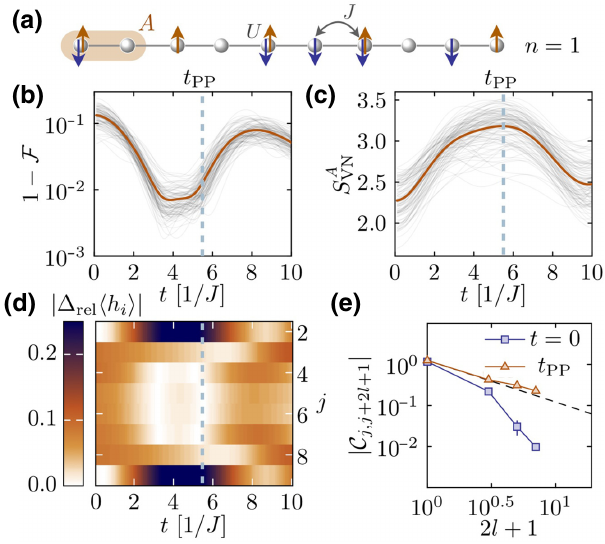
FIG. 14. Purification preparation for a ten-site Hubbard model with U / J = 1 and 50% filling ( n = 1). (a) Sketch of the Fermi- Hubbard chain with n = 1. (b) Fidelity [Eq. (10) in main text] computed between a bulk subsystem ( B ) of the ten-site chain and a corresponding subsystem in the ground state of a 200- site chain, during time evolution with the deformed Hamiltonian. The gray lines show the results for 100 different random super- positions for the initial state (see main text). The bold solid line represents the mean over all experiments for different initial states. (c) Analogous plot to (b) for the von Neumann entan- glement entropy of the subsystem A indicated in (a). (d) Local (cid:7)ˆ energy densities h i (cid:3) (see main text) for an eight-site bulk of the chain as a function of time. (e) Decay of the two-point cor- relation function C j , j + 2 l + 1 = in the initial state and in the state at the optimal time t PP . The black dashed line shows the decay of correlations in the ground state of a 200-site